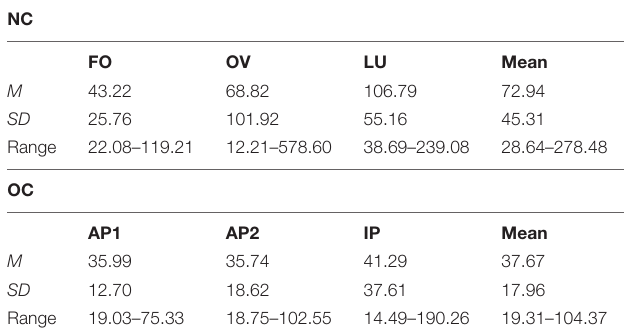
TABLE 3 | Mean (M), standard deviation (SD) and range of progesterone concentration in pg/ml across follicular (FO), ovulation (OV) and luteal phase (LU) in naturally cycling (NC) women and across active OC pill phase one (AP1), active OC pill phase two (AP2) and the inactive OC pill phase (lP) in oral contraceptive (OC)